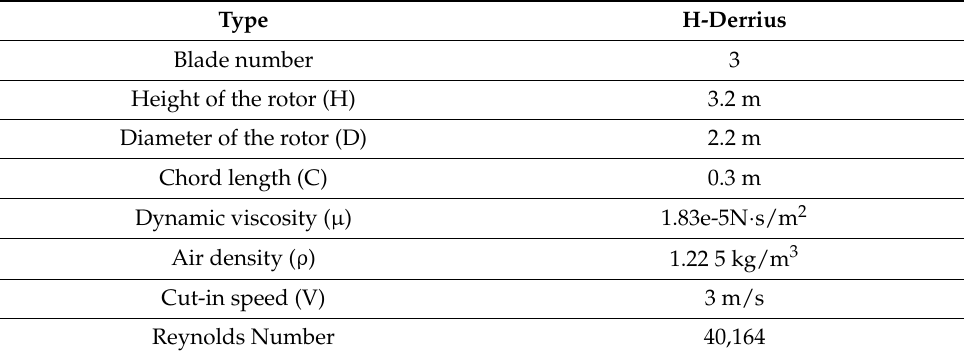
Table 2. Specifications of wind turbine.